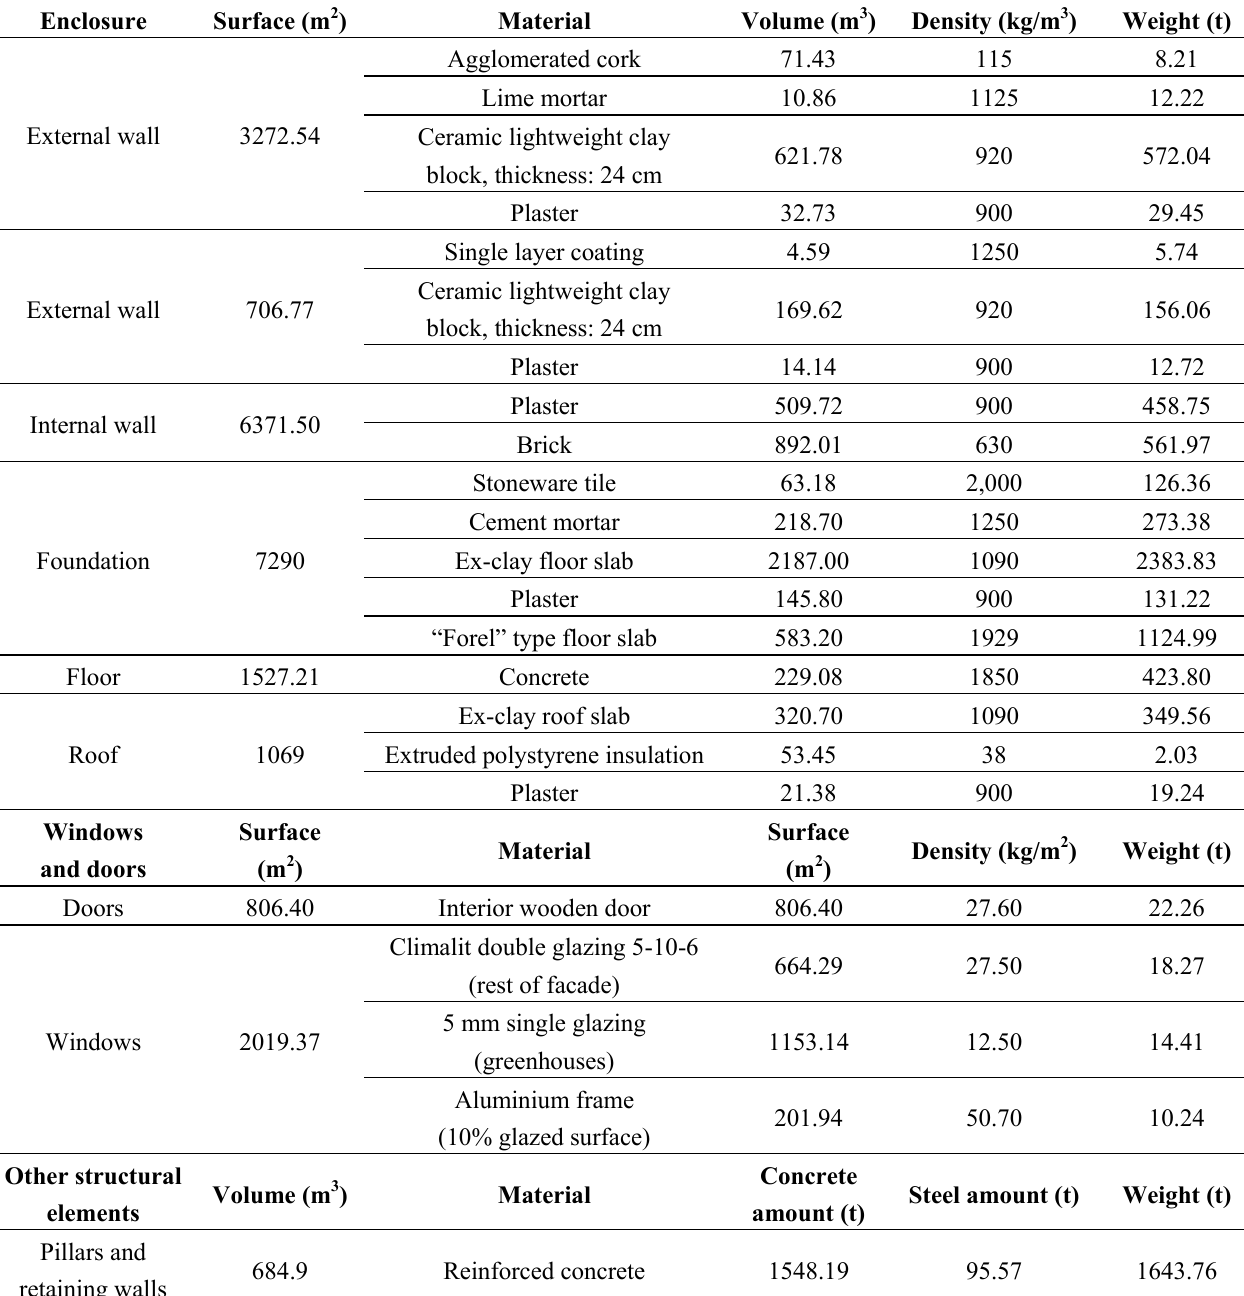
Table 3. Inventory of materials of the building enclosure and